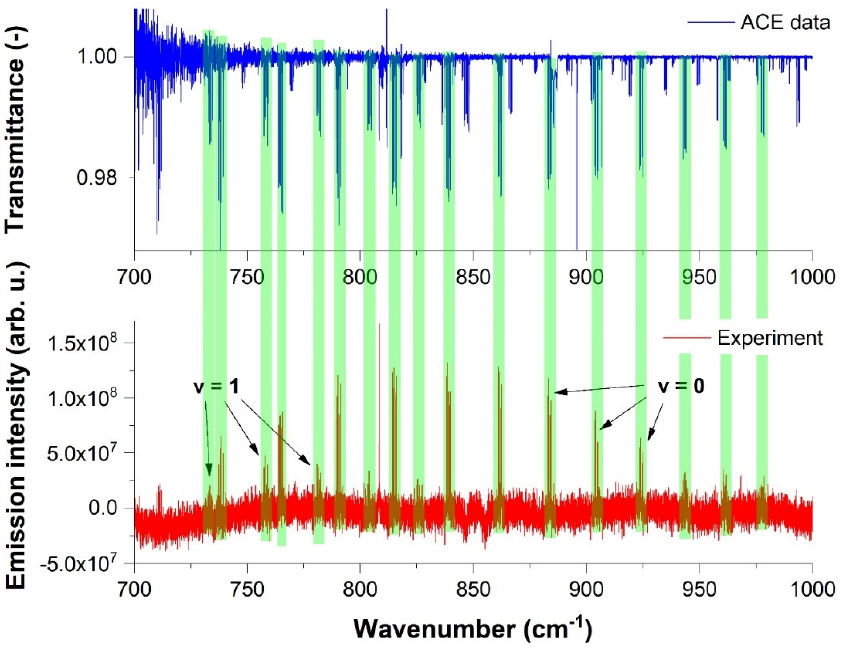
Figure 8. Comparison of the experimental OH spectrum with ACE solar spectrum in the 700–1000 cm − 1 spectral range.